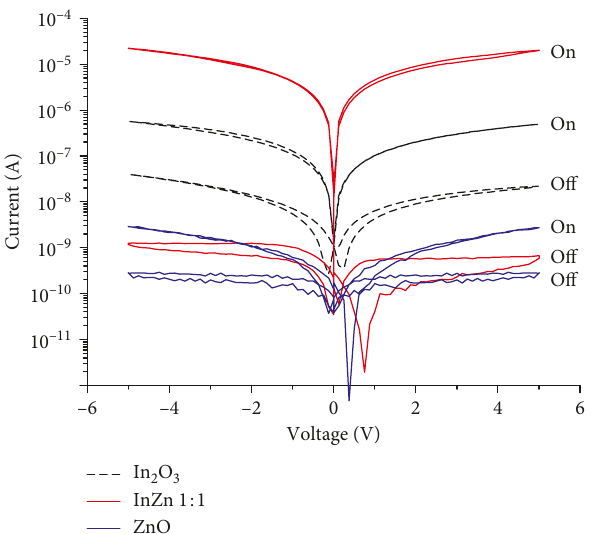
Figure 5: I - V characteristics of samples IZO1 (In 1:1), and IZO9 (ZnO) when they are irradiated with UV (“on”) and under natural illumination (“off”).